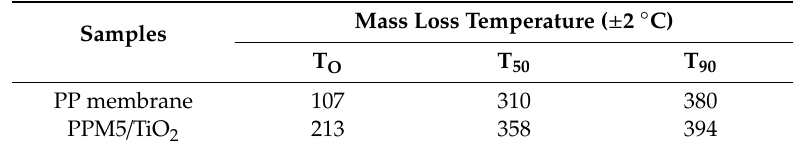
Table 1. Mass-loss temperature obtained from thermogravimetric analysis (TGA) thermogram of PPM and PPM5 / TiO 2 .